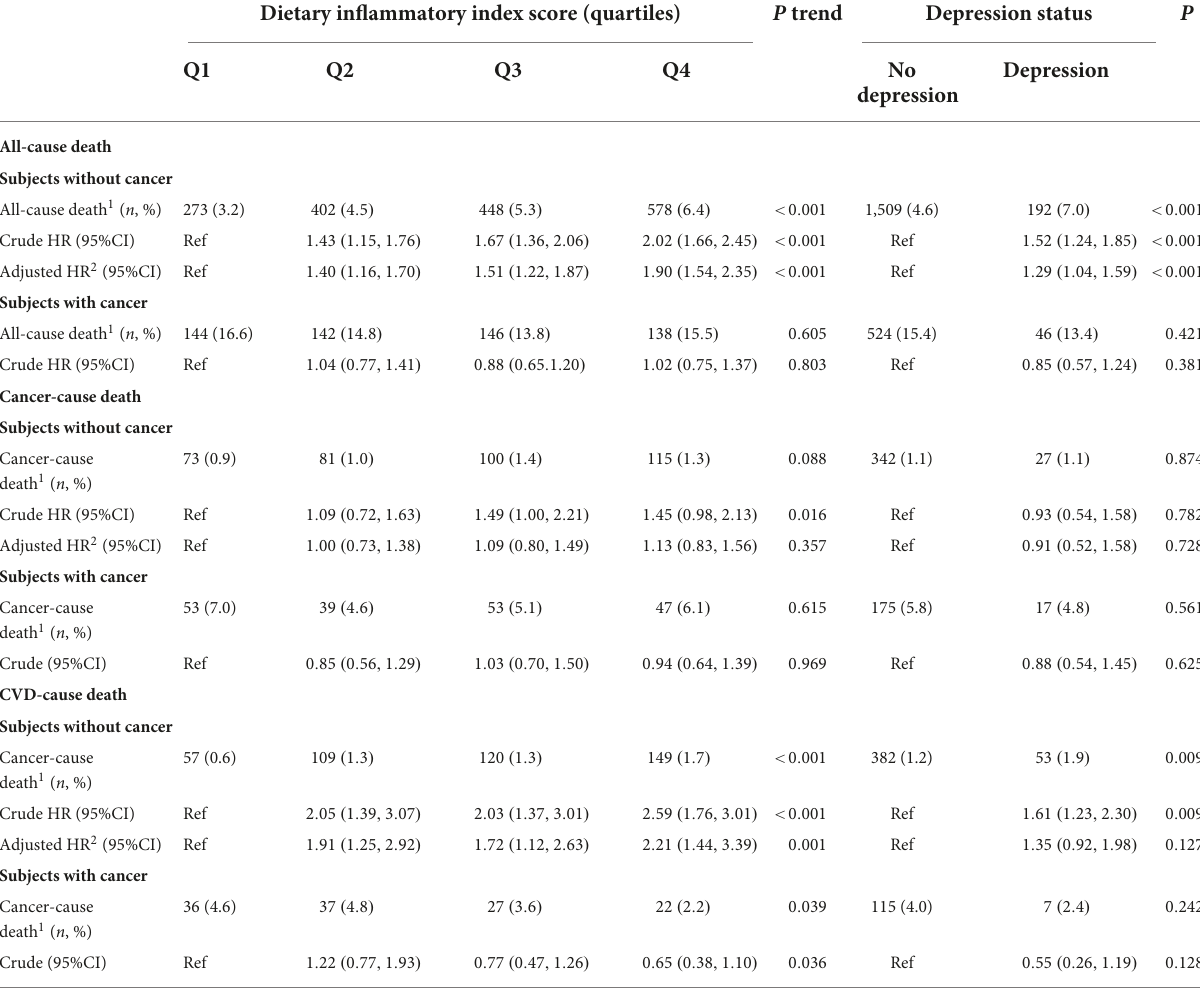
TABLE 3 Association of dietary inflammatory index score and depression status with all-cause, cancer-cause and cardiovascular disease (CVD)-cause death in NHANES 2007–2018. Dietary inflammatory index score (quartiles) P trend Depression status